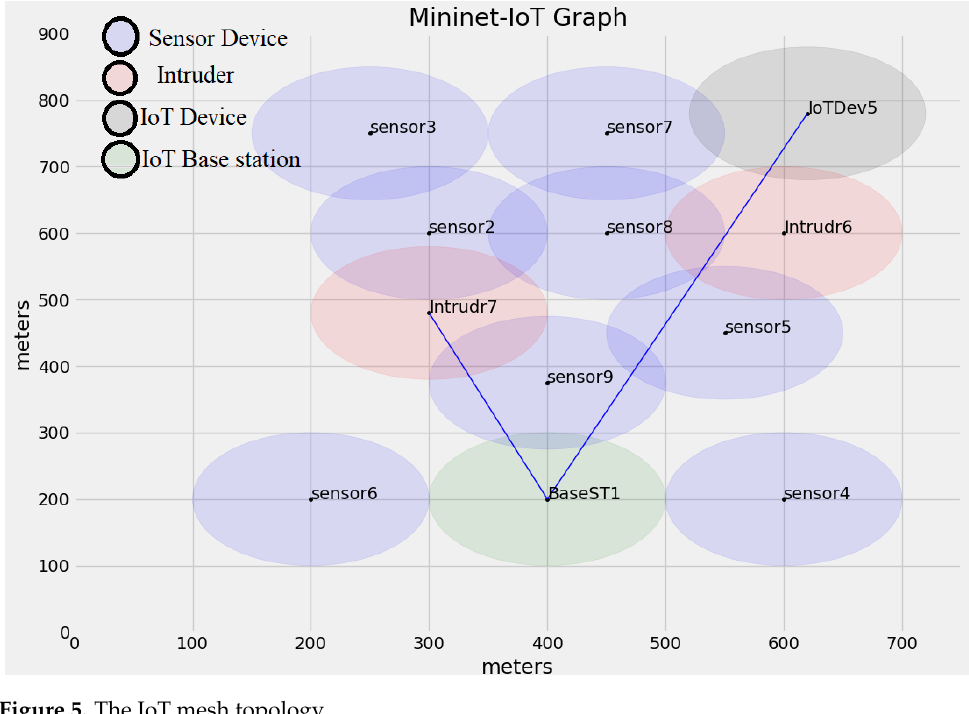
Figure 5. The IoT mesh topology. Table 4. Experiment configuration.